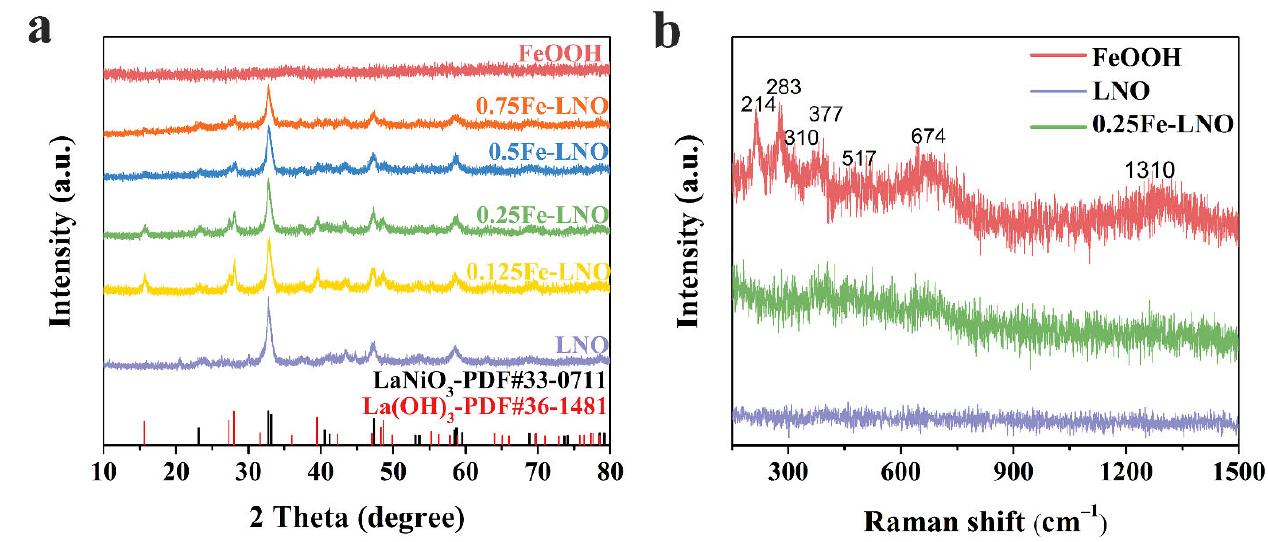
Figure 1. ( a ) XRD pattern of LNO, FeOOH and Fe-LNO samples ( b ) Raman spectrum of LNO, FeOOH and 0.25Fe ‐ LNO.